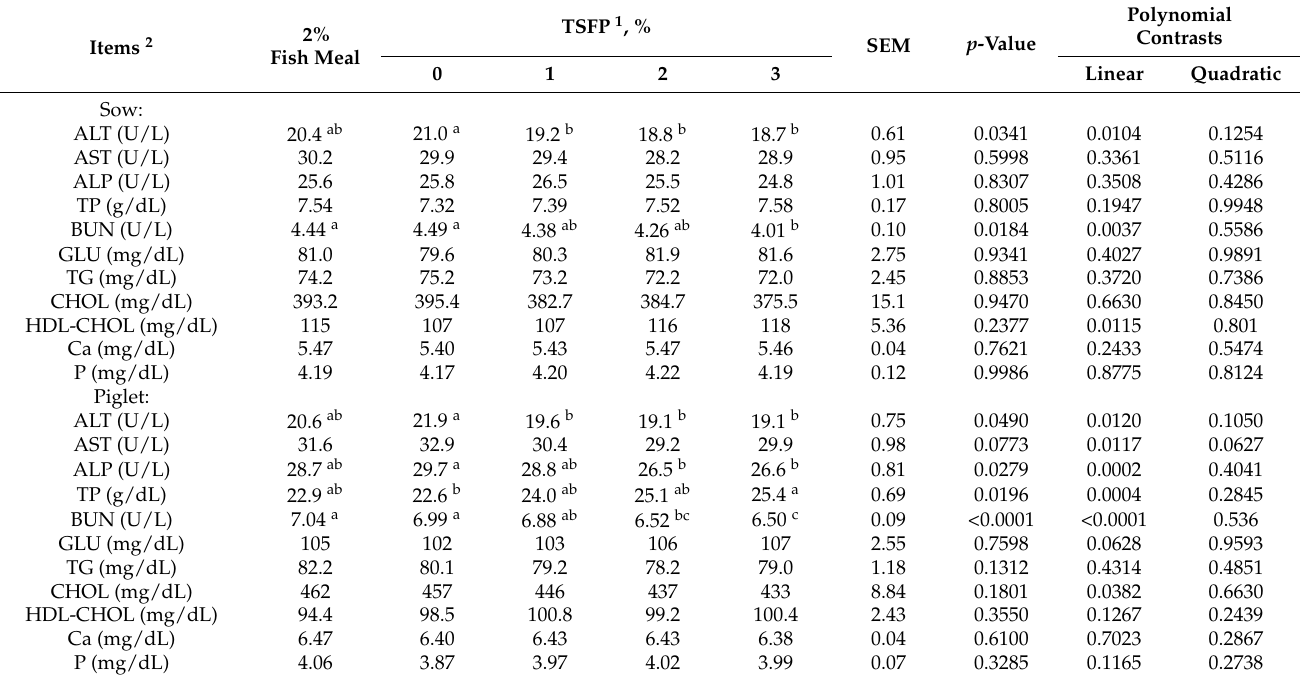
Table 4. The effects of two-stage fermented product on clinical blood biochemistry of sow and their piglets during lactation